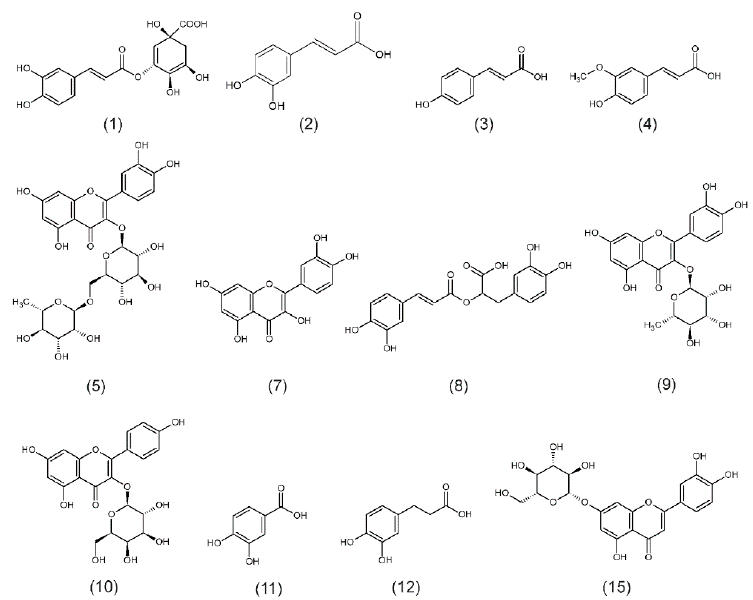
Figure 2. The chemical structures of the identified compounds: 1—chlorogenic acid, 2—caffeic acid, 3— p -coumaric acid, 4—ferulic acid, 5—rutoside, 7—quercetin, 8—rosmarinic acid, 9—quercitrin, 10—trifolin, 11—protocatehuic acid, 12—hydrocaffeic acid, 15—cynaroside. Table 1. The polyphenolic composition of F. alnus and P. harmala leaf extracts (mg/100g DW ± SD).